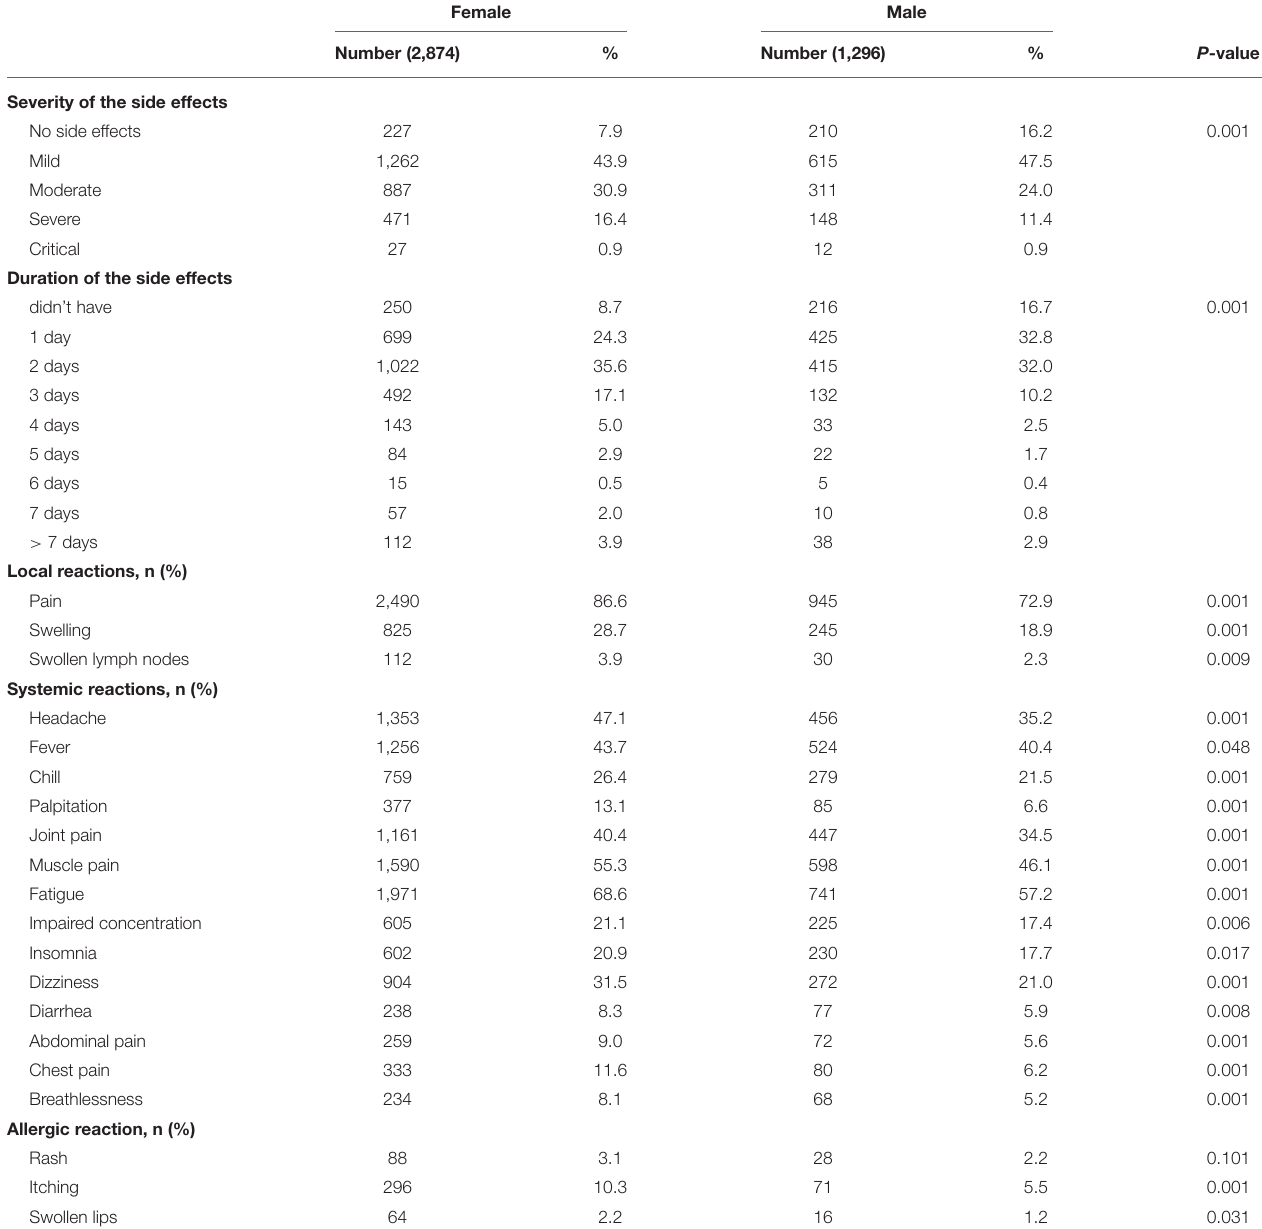
TABLE 3 | The post vaccine adverse effects after vaccination in male and female subjects. Female Male Number